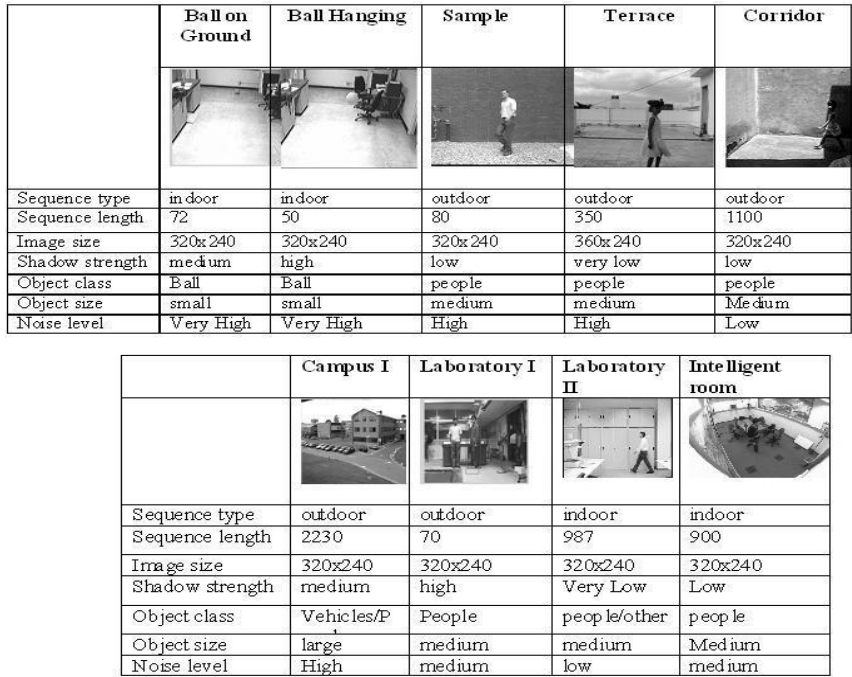
Figure 4. Information about the dataset.